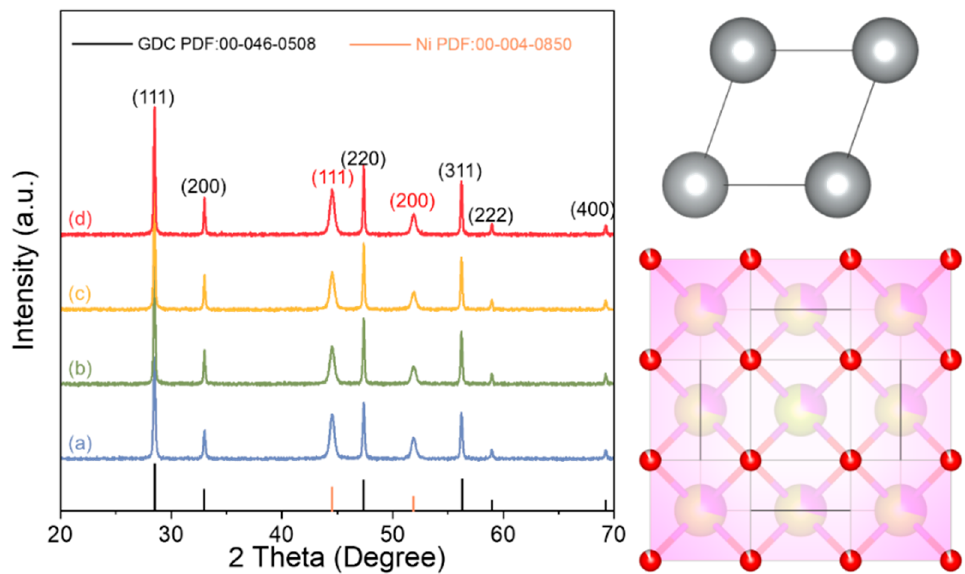
Figure 1. XRD patterns of the reduced Ni/Gd x Ce 1-x O 2- δ catalysts. (a) Ni/Gd 0.1 Ce 0.9 O 2- δ , (b) Ni/ Gd 0.2 Ce 0.8 O 2- δ , (c) Ni/Gd 0.3 Ce 0.7 O 2- δ , and (d) Ni/Gd 0.4 Ce 0.6 O 2- δ . Table 1. The crystallite size and lattice constant of the Ni/Gd x Ce 1-x O 2- δ catalysts. Crystallite Size (nm) Lattice Constant (Å) Ni/Gd 0.1 Ce 0.9 O 2- δ